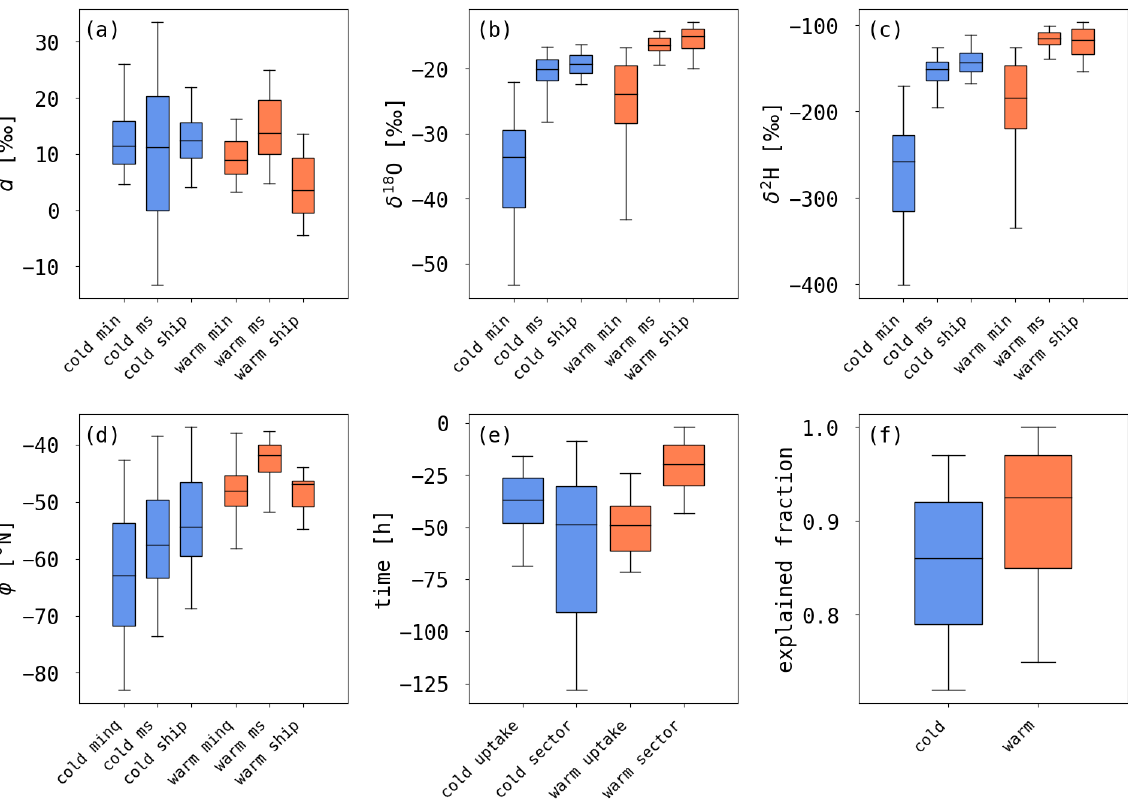
Figure 10. Box plots with information derived from COSMO iso trajectories for cold (blue) and warm (orange) temperature advection events. Boxes show the median (black horizontal line in box), interquartile range (boxes) and [5, 95] percentile range (whiskers) of (a) d , (b) δ 18 O, (c) δ 2 H and (d) latitude φ at minimum specific humidity along the trajectories (minq), the moisture source site (ms) and the ship location (ship), (e) the weighted mean moisture uptake time before arrival (uptake) and the entrance time into the cold and warm sectors (sector), and (f) the specific humidity fraction explained by the moisture source